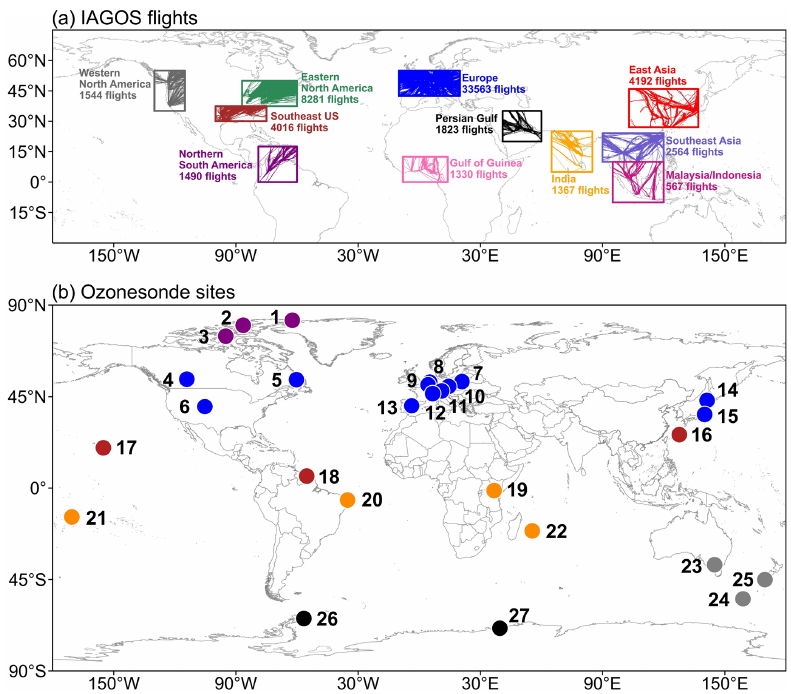
Figure 1. IAGOS and ozonesonde measurements of tropospheric ozone used in this study. The upper panel shows the map of the 11 study regions with frequent IAGOS sampling between 1995 and 2017 (grouped by color). The flight tracks are indicated in the boxes showing western North America, eastern North America, Europe, East Asia (including northern China, the Korean Peninsula, and part of Japan), the Southeast United States, northern South America, the Gulf of Guinea, the Persian Gulf, India, Southeast Asia, and Malaysia/Indonesia. The lower panel shows the location of selected ozonesonde sites in 1995–2017 used in this study, grouped by six latitude bands with an interval of 30 ◦ as denoted by different